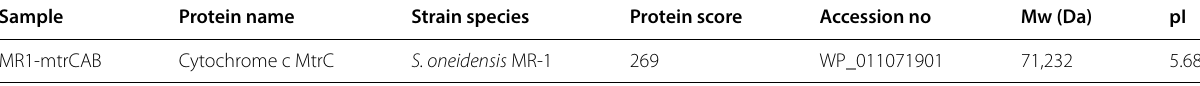
Table 3 MASCOT protein identification of Shewanella oneidensis MR-1 from heme staining